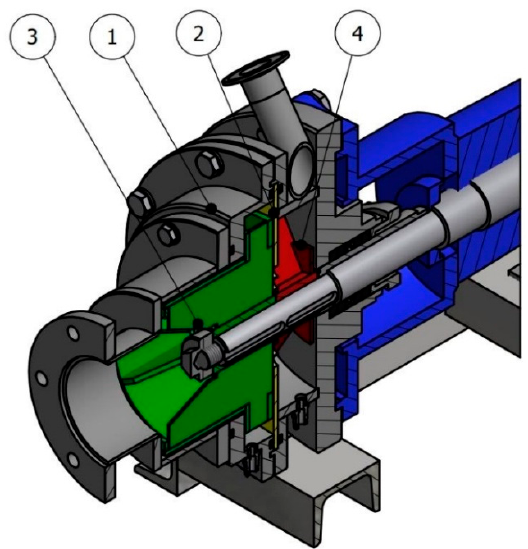
Figure 2. Axionometric drawing of the tested pump: 1—casing; 2—baffle plate; 3—liquid pumping rotor; 4—foam breaking rotor.